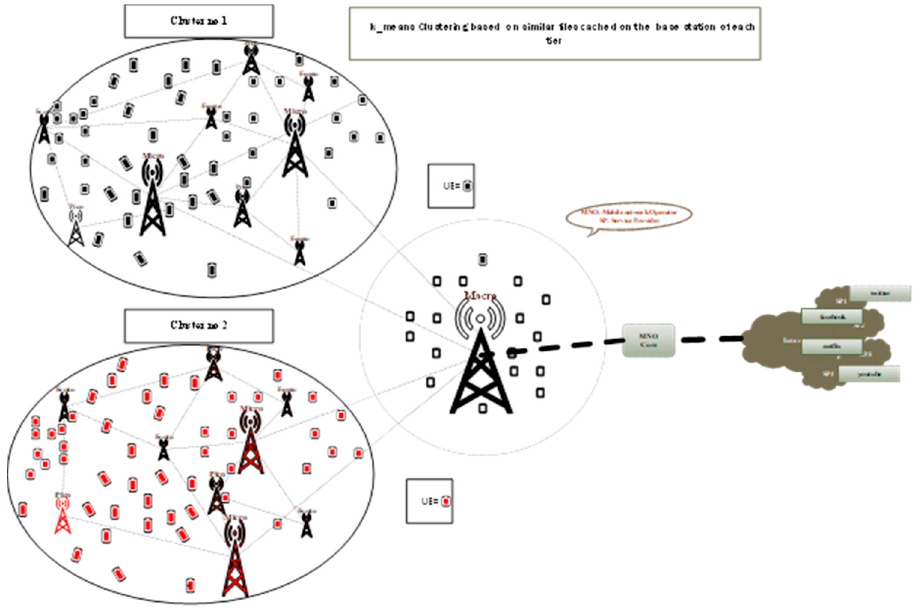
Figure 2. The proposed Algorithm 3 is: